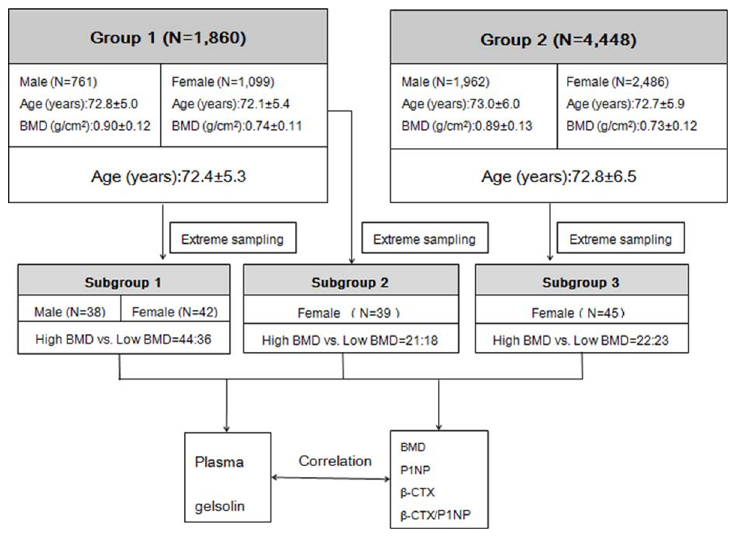
Fig 1. An overview of the flow chart for this